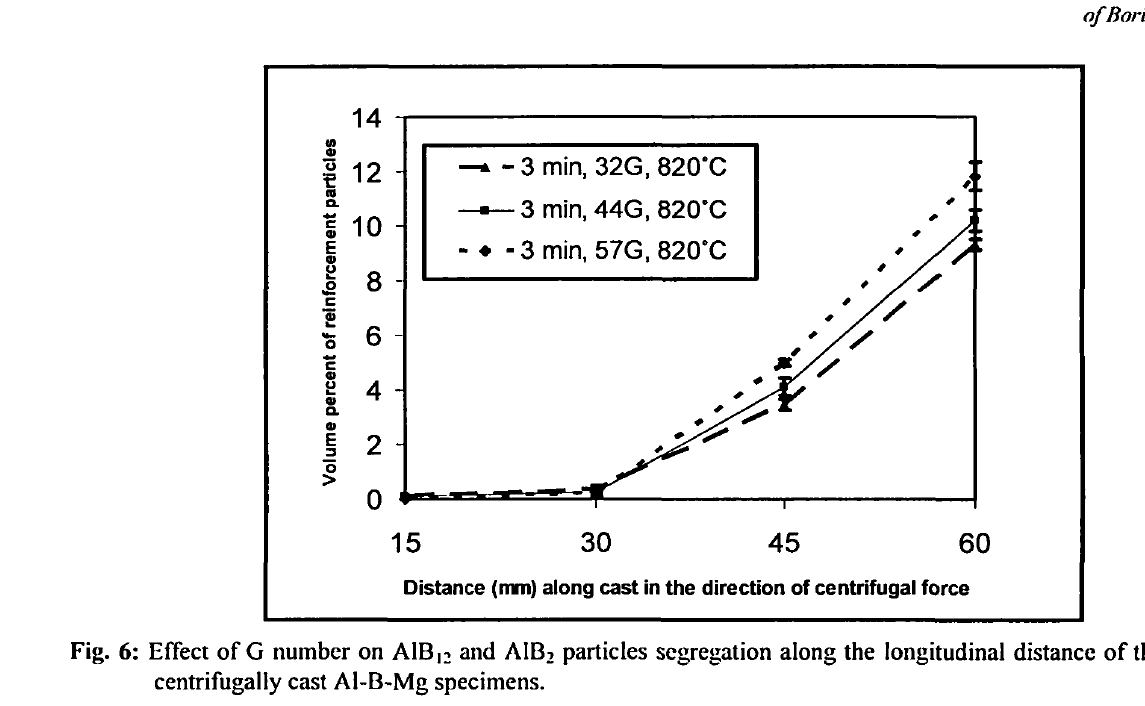
Fig. 6: Effect of G number on AlBn and AIB particles segregation along the longitudinal distance of the cylindrical 2 centrifugally cast Al-B-Mg